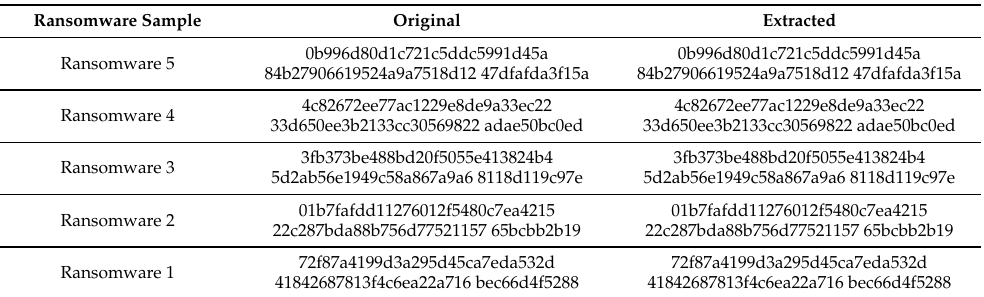
Table 8. Hash-256 values of ransomware samples before and after implementing the extraction